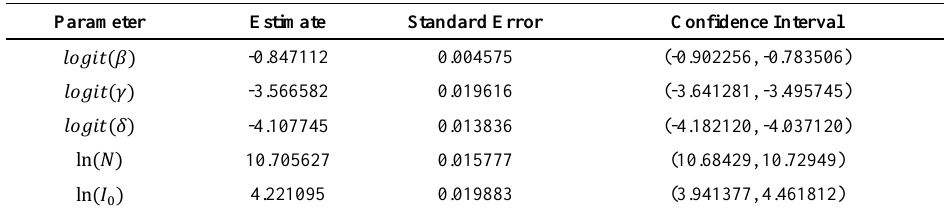
Table A12. Lombardy. Estimates, asymptotic standard errors, and 95% profile likelihood mCIs for the parameters of the SIRD model (12).